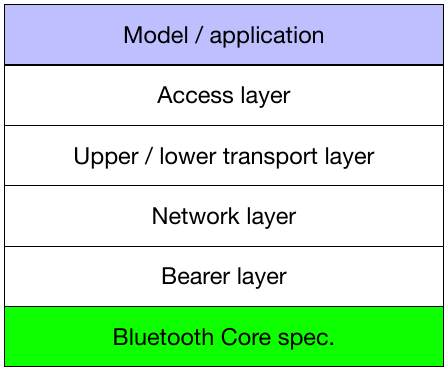
Figure 2. Bluetooth mesh layered